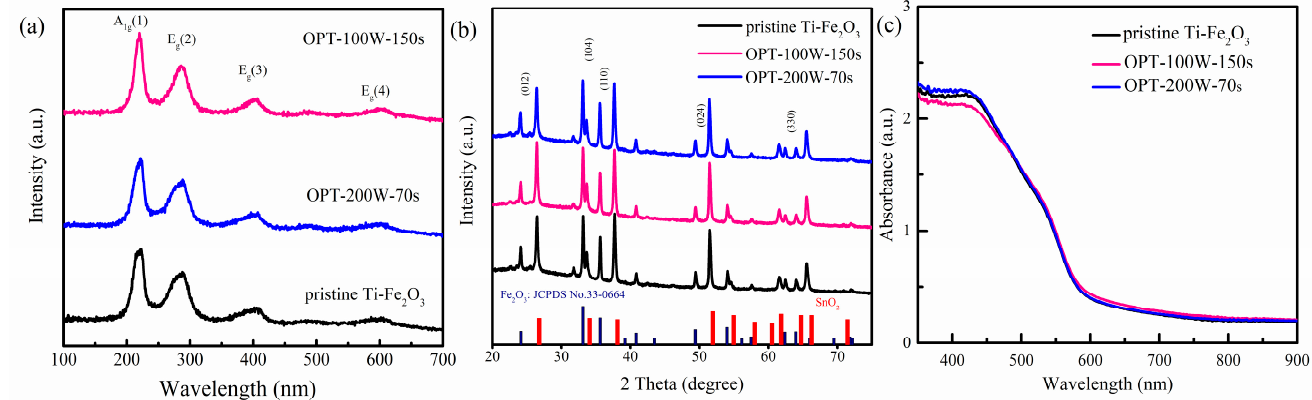
Figure 2. ( a ) Raman, ( b ) X-ray diffraction (XRD) patterns, and ( c ) absorption spectra of pristine Ti-Fe 2 O 3 , OPT-100W-150s, and OPT-200W-70s photoanodes, respectively.